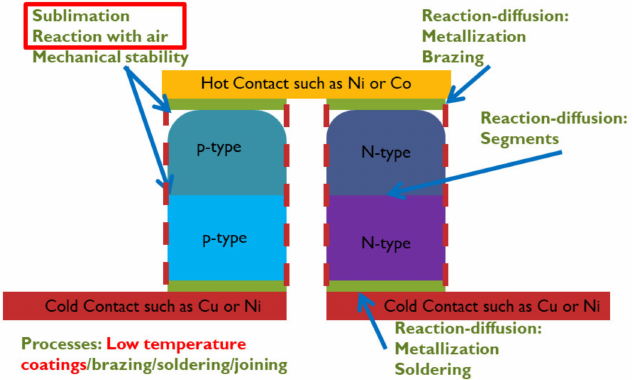
Figure 1. Some of the challenges in turning thermoelectric devices into generators. In red the challenges of sublimation and oxidation are marked, with the hot-side of the element showing sublimation. a suggested coating is marked in a dashed red